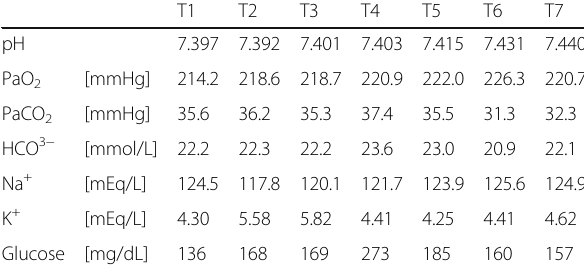
Table 1 Results of arterial blood gas